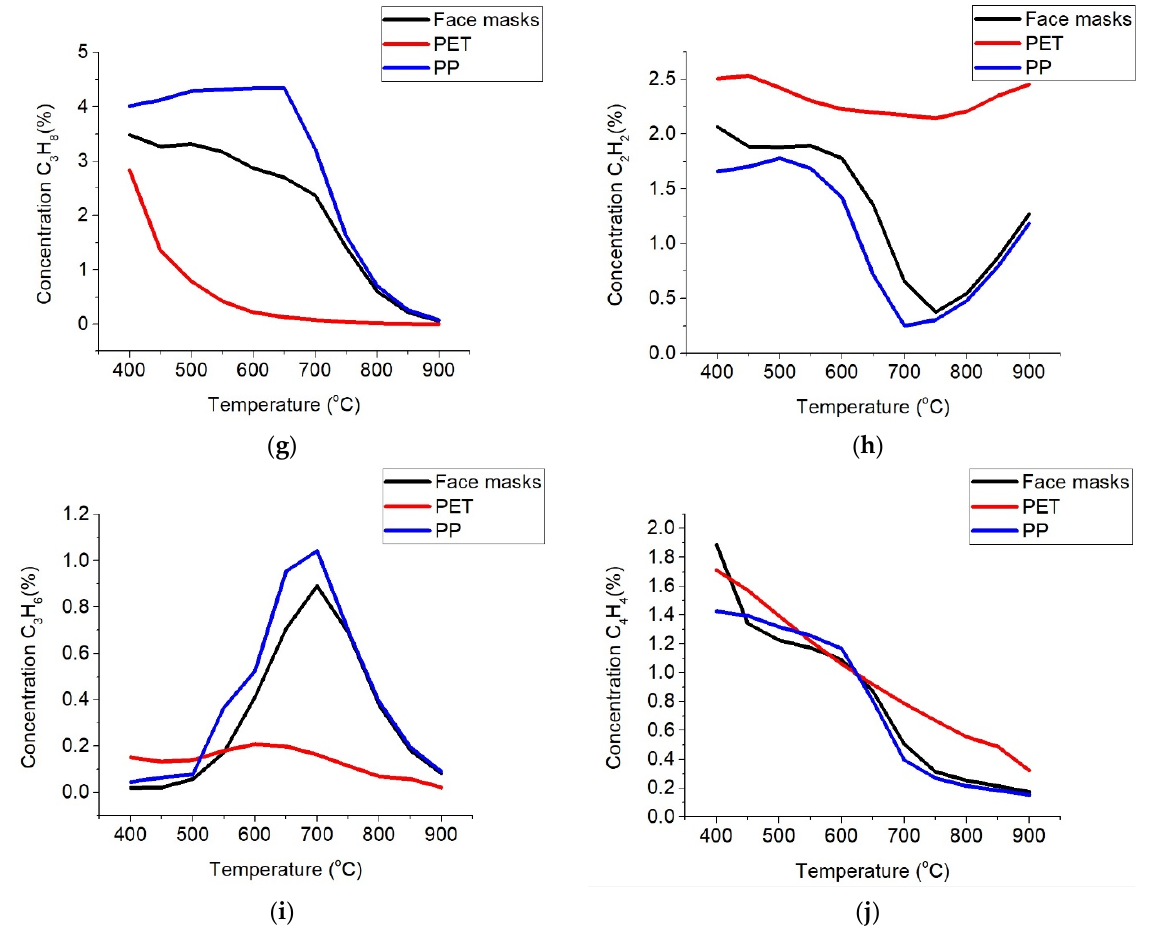
Figure 8. Influence of temperature on formation of (a) CO, (b)H 2 , (c)CH 4 , (d) C 6 H 6 , (e) C 2 H 4 , (f) C 2 H 6 , (g) C 3 H 8 , (h) C 2 H 2 , (i) C 3 H 6 , (j) C 4 H 4 .